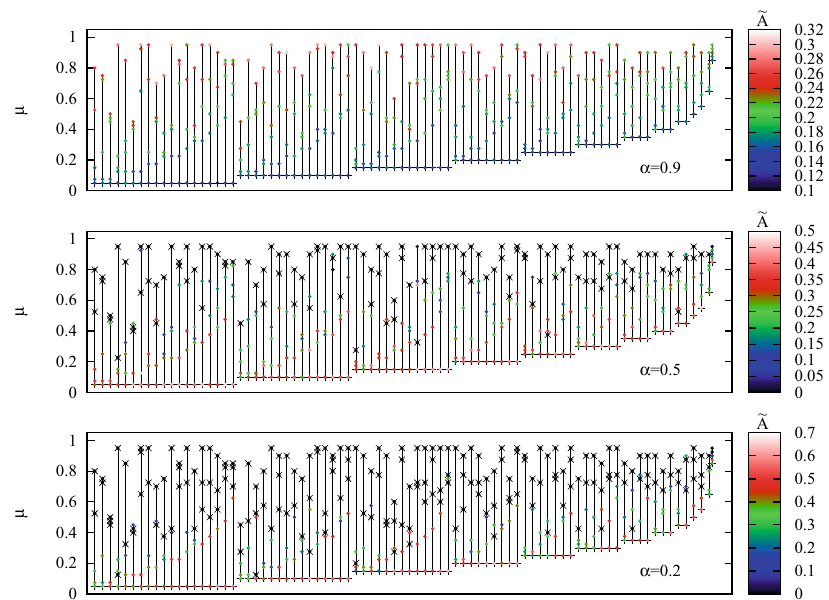
Fig.5 We represent the audiences of N = 5 outlets after 20years of evolution for different combinations of the editorial standards of the outlets. The top, center and bottom panels show the audiences when α = 0 . 9, α = 0 . 5, and α = 0 . 2, respectively. Each vertical line—connecting five dots—corresponds to a single simulation, where the lowest dot corresponds to μ 1 and the highest dot to μ 5 . The color of a dot represents the final audience of the outlet, as indicated in the palette. The simulations shown are a small sample of all possible μ i combinations, with i = 1 ,..., 5. The value of μ 1 increases from left to right to facilitate the presentation. The crosses indicate the outlets that lost all their audience and went out of business